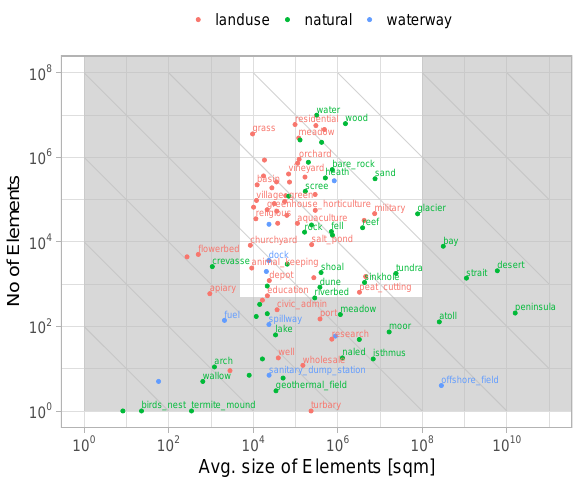
Figure 2. OSM LULC tags by their frequency and size, based on all OSM LULC polygons in 2021. Colors represent the tag-key. The gray horseshoe defines an area where tags can be classified as too small (too detailed), too large (too general) or too rare (not in use). Diagonal grid lines define tags of equal importance meaning equal global areal